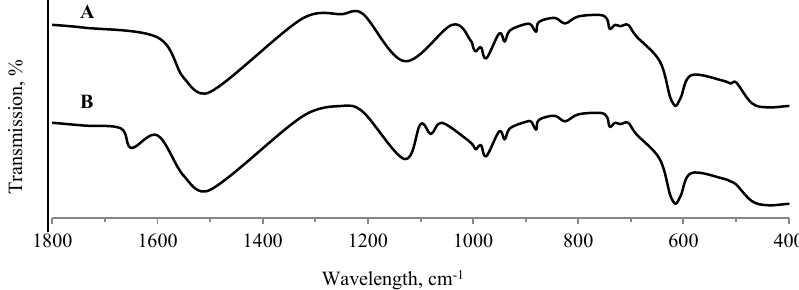
Fig. 5. IR spectra of uncapsulated and encapsulated sodium ferrate: A) uncoated sodium ferrate; B) encapsulated sodium